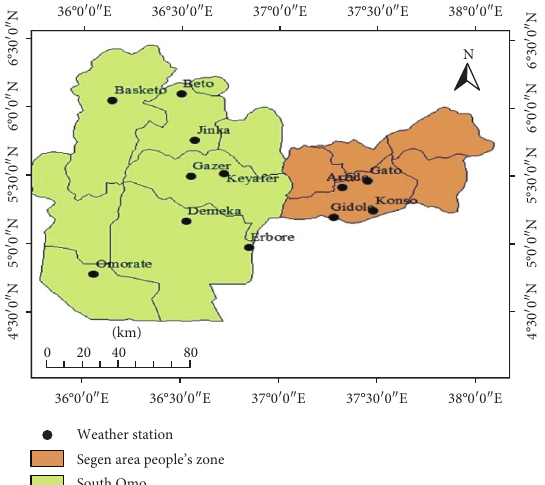
Figure 1: Map of the study area.